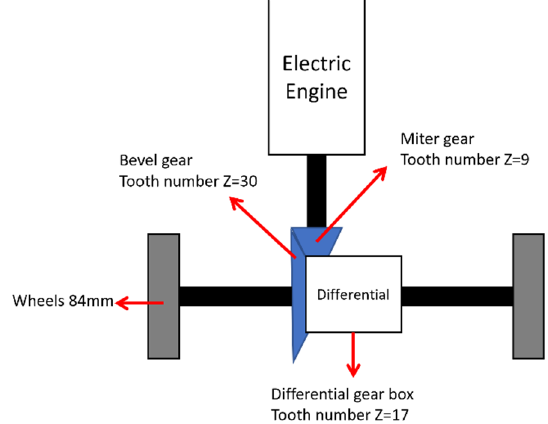
Figure 3. Gear system for the transmission.